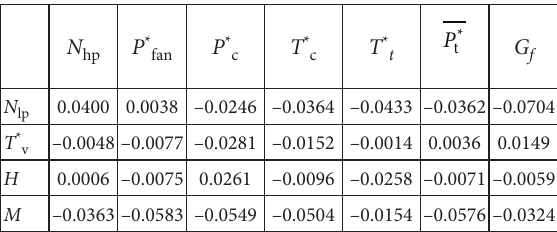
Table 1. Correlation factors between diagnostic deviations and